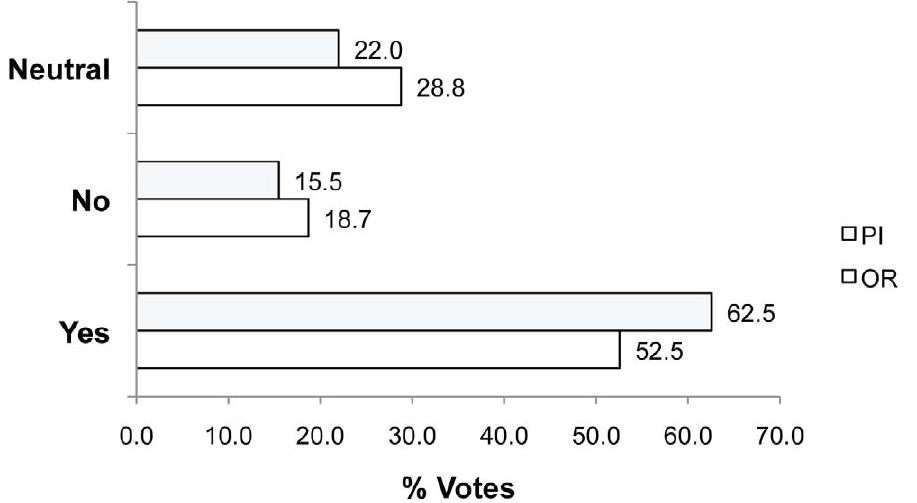
Figure 9. Percent of Yes, No and Neutral votes in response to Q7. Question 7: Should financial cost be a factor when making decisions about animal welfare initiatives?